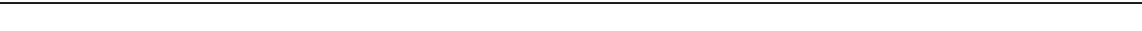
Fig. 3 PCN production is enhanced in the ZJU60 – Fg interaction. a Colony morphology of co-cultured ZJU60 and Fg on Warkingsman ’ s agar (WA) agar medium after 5 days of incubation. The green pigments (PCN) are indicated by arrows. Bar = 1 mm b Features of fungal mycelium after 5 days of co-culture with ZJU60 in WA liquid medium. The details of the green crystals are enlarged (right-hand panel), bar = 1 mm. c Relative PCN production of ZJU60 and a ZJU60 – Fg co-culture in WA liquid medium. d ZJU60 bio fi lm features on the mycelium of Fg during co-culture. e Bacterial colonization features of the Δ phzA-H mutant on the mycelium of Fg during co-culture. f The total number of planktonic and mycelium-associated bacterial cells during co-culture for two bacterial – fungal combinations after 5 days of incubation. g The population of fungal mycelium-associated bacterial cells after 5 days of co-culture, excluding the planktonic cells. h Bio fi lm formation by ZJU60 and Δ phzA-H in WA and yeast extract peptone dextrose (YEPD) media. The submerged bio fi lm was stained with crystal violet (CV, bottom panel). The average amount of CV retained in the bacterial biomass was quanti fi ed (right-hand panels) from three independent experiments consisting of four internal replicates. i PsI polysaccharides in the bio fi lm matrix of ZJU60 and Δ phzA-H formed in YEPD and WA media were detected by immunoblotting with anti-Psl serum. j Morphological features of the individual bio fi lm of ZJU60 and Δ phzA-H were visualized by SEM. Data presented are the mean ± s.d. ( n = 3). Bars followed by the same letter are not signi fi cantly different according to Student ’ s t test at P =